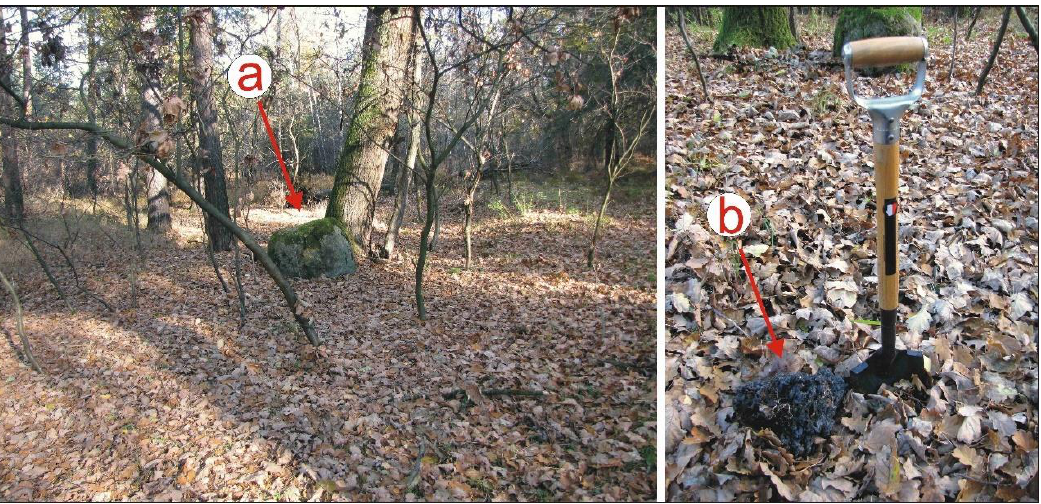
Figure 6. A junction of former forest roads marked by: ( a ) a large erratic boulder; ( b ) a crumb of smelter slag used to harden the road surface — central part of the study area (photo: J.M. Waga).